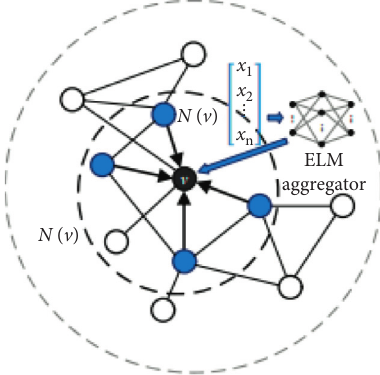
Figure 4: Aggregation using ELM aggregator on node v